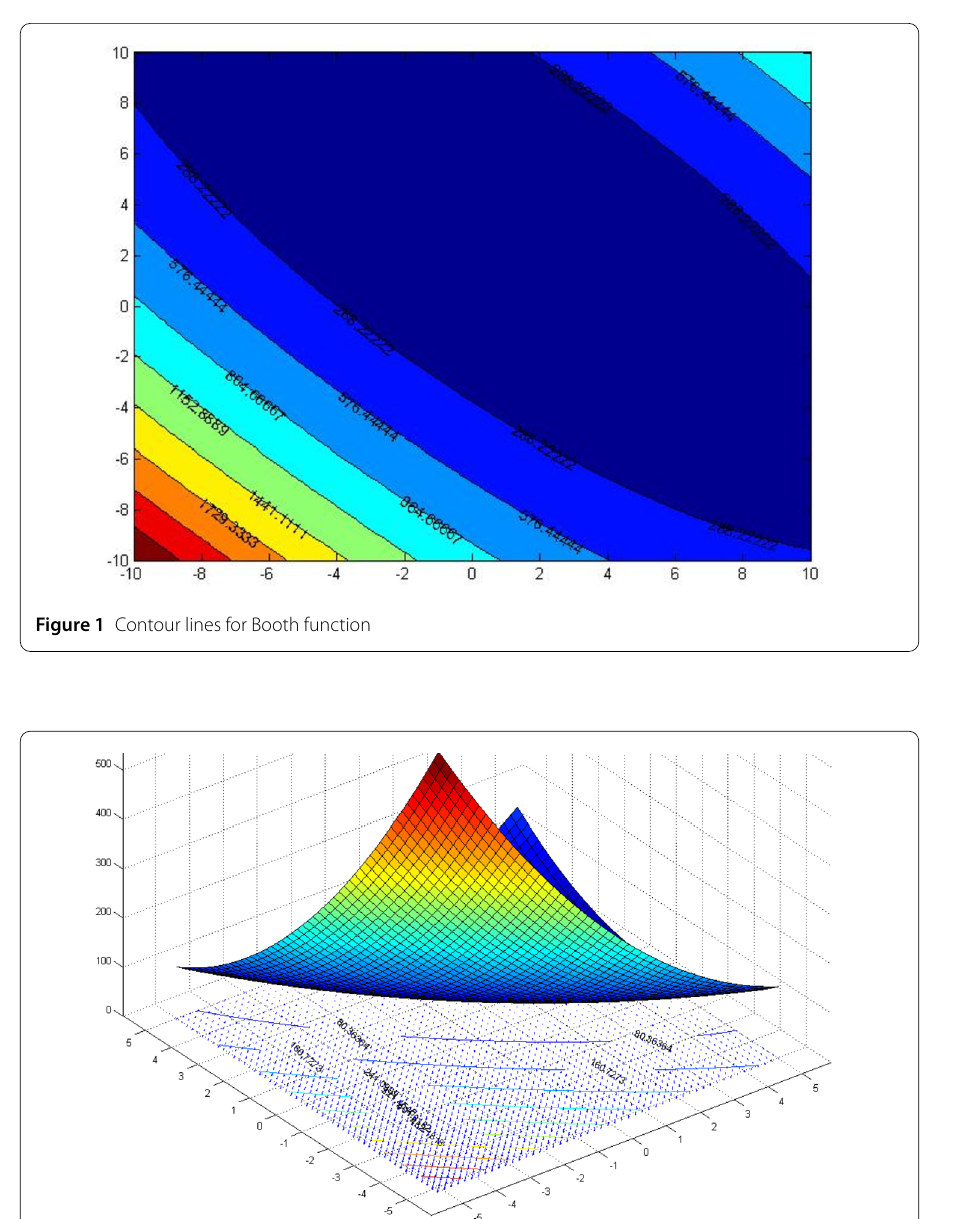
contours, and Booth function are plotted, which clearly portrays the function’s minimum using the function or contour line graph. Despite the steepest descent method robustness, it is not efficient due to CPU time for large-dimensional functions. Thus, using the CG method will avoid the orthogonality between the ∇ f and the search direction. Figure 3 shows the angle between the ∇ f and d k using the CG